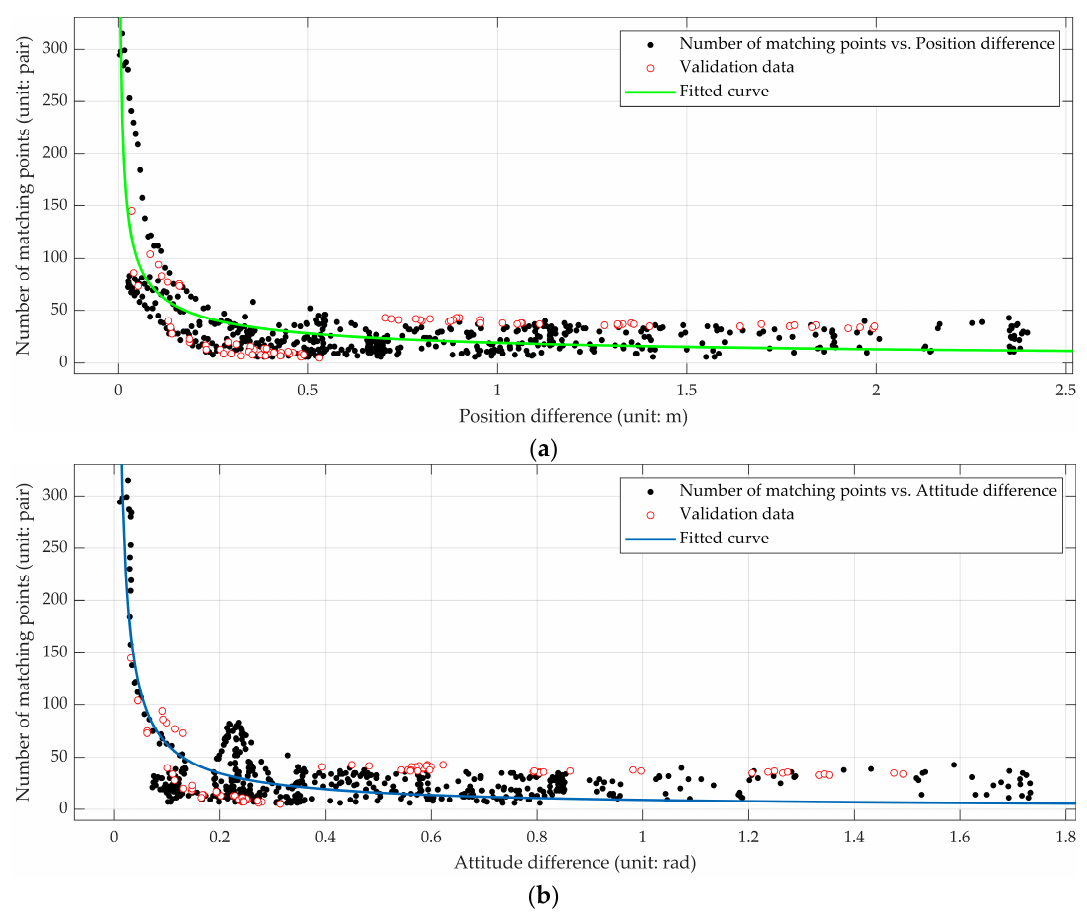
Figure 3. Relationship between number of matching points and corresponding pose difference. ( a ) Fitted curve of number of matching points vs. position difference; ( b ) fitted curve of number of matching points vs. attitude difference. Table 1. The root mean square errors (RMSEs) of fitted curves and validation data in Figure 3. Fitted Curves RMSE of